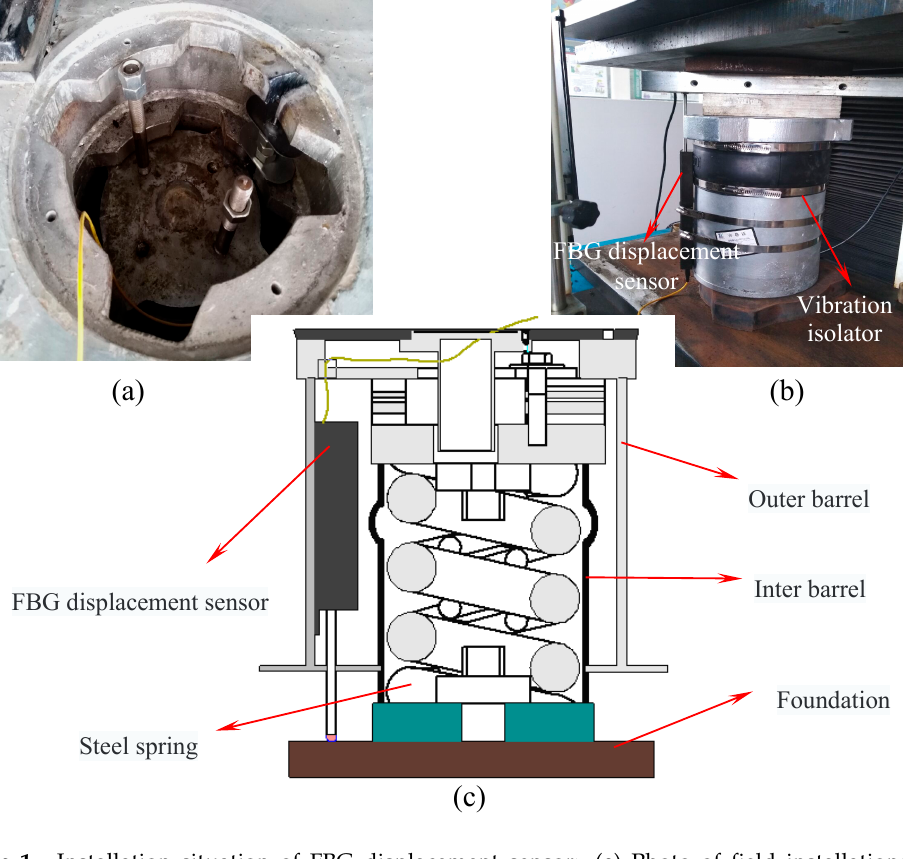
Figure 1. Installation situation of FBG displacement sensor: ( a ) Photo of field installation; ( b ) Installation testing; ( c ) Schematic diagram of installation.